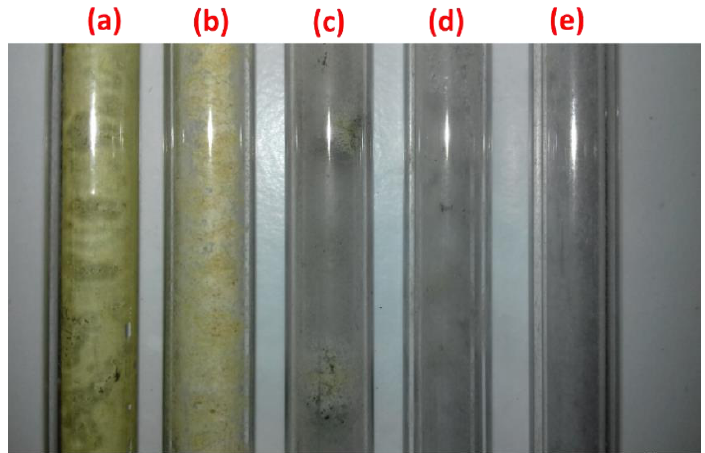
Figure 5. Formation of deposits on the inner surface of the dielectric quartz tube after plasma reaction: ( a ) the blank reactor, ( b ) the packed reactor with γ -alumina, ( c ) the packed reactor with 0.5 wt% Pd / γ -alumina, ( d ) the packed reactor with 1.0 wt% Pd / γ -alumina, ( e ) the packed reactor with 5.0 wt% Pd / γ alumina.